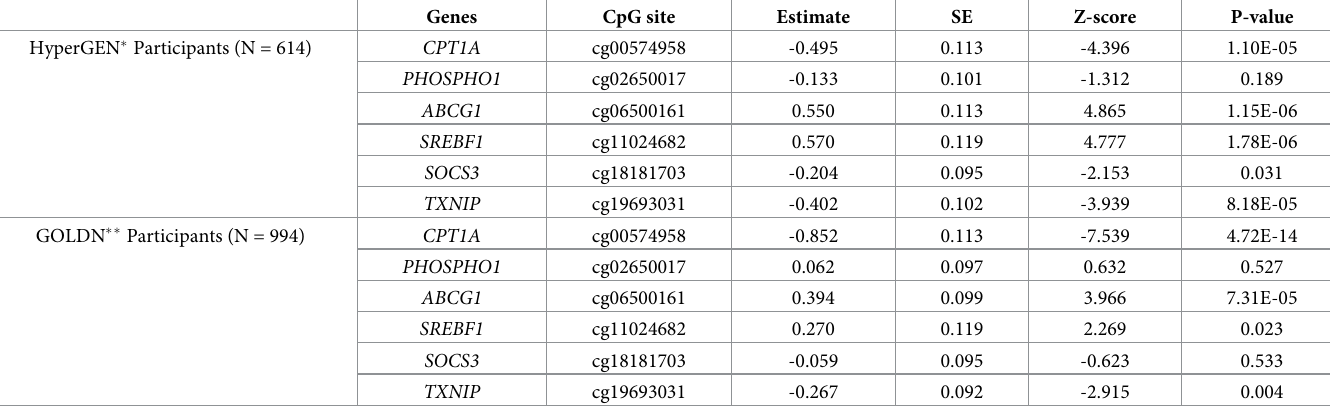
Table 3. Single CPG and MetS association results for GOLDN and HyperGEN.